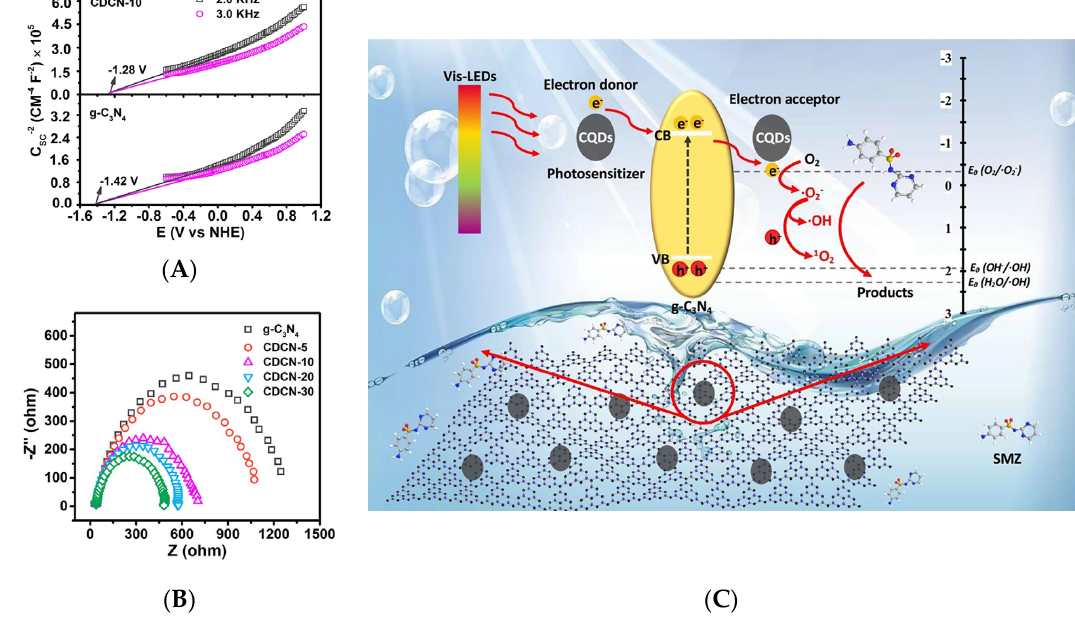
Figure 7. ( A ) Mott–Schottky plots. ( B ) Electrochemical impedance spectroscopy of g-C 3 N 4 and CDs/g- C 3 N 4 . ( C ) Photocatalytic mechanism of sulfamethazine catalyzed by CDs/g-C 3 N 4 under visible LED irradiation; Reprinted with permission from [59] published by Elsevier,